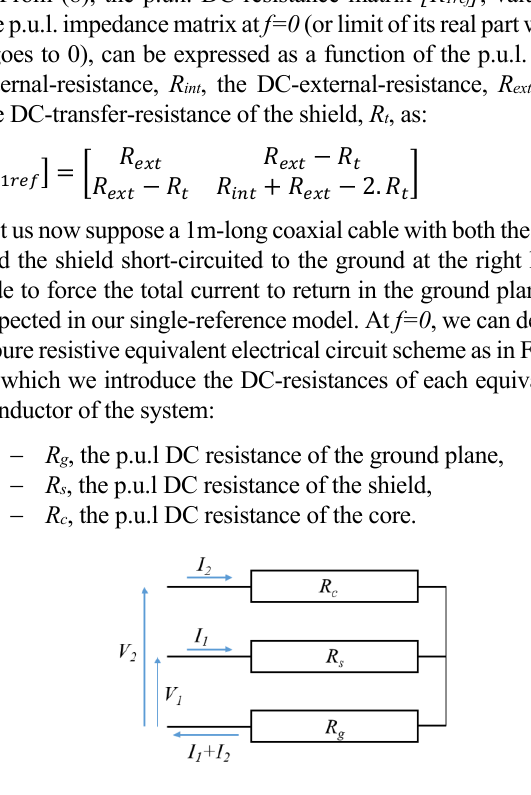
FIGURE 4. Equivalent resistive electrical circuit model of the 1m-long short- circuited coaxial cable problem V i(i=1,2) and I i(i=1,2) are the TL voltages and currents as defined